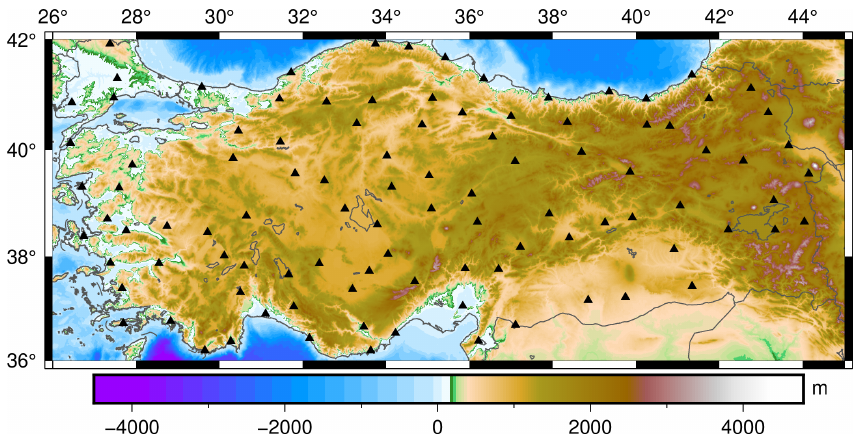
Figure 3. Location of the GNSS/leveling benchmarks (black triangles) over the topography of